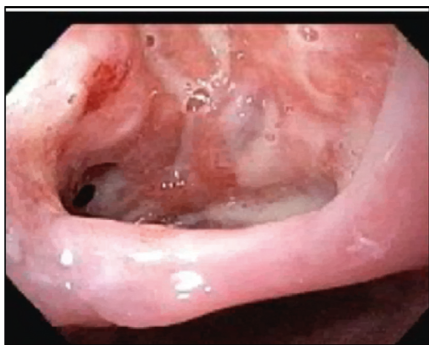
Figure 3: Esophagogastroduodenoscopy (EGD). The upper esophagus at 25cm showed a 2.5 cm defect with a visible fistulous track to the trachea.